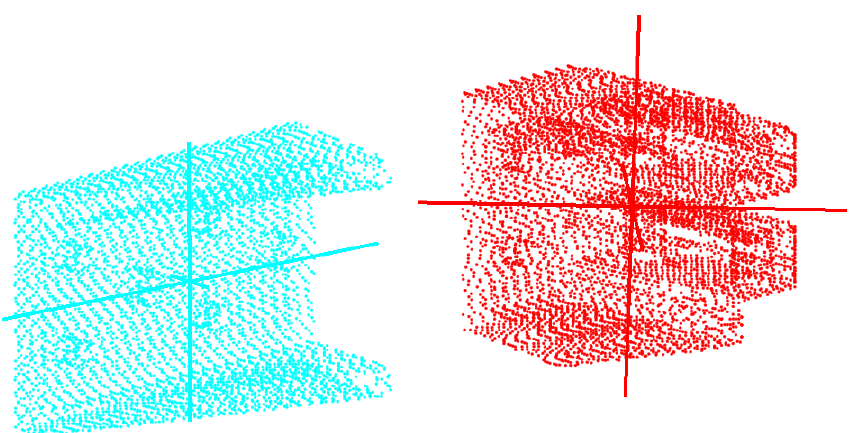
Figure 3. Principal Component Analysis (PCA) decomposition of the point cloud from Figure 2.